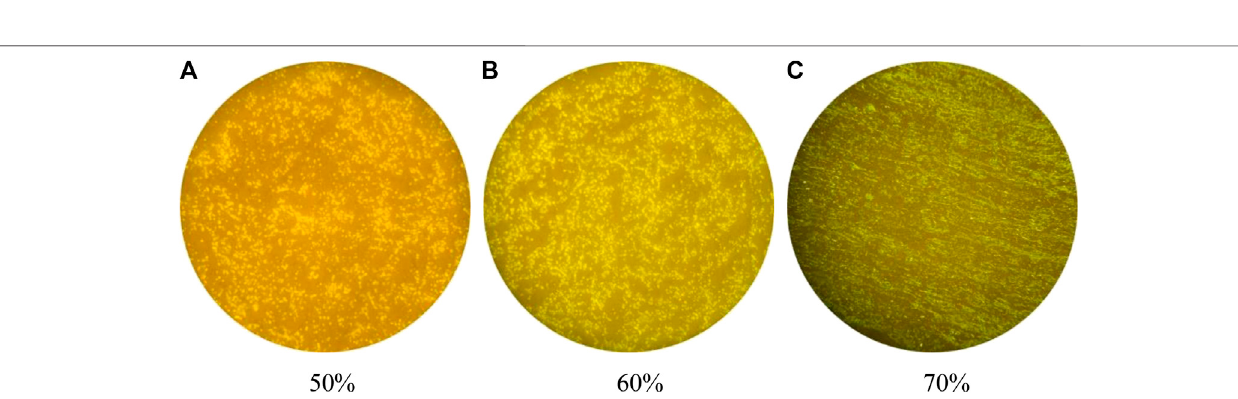
FIGURE 10 | Fluorescence images of asphalt modi fi ed by high-content activated rubber powder. (A) 50%, (B) 60%, and (C) 70%.